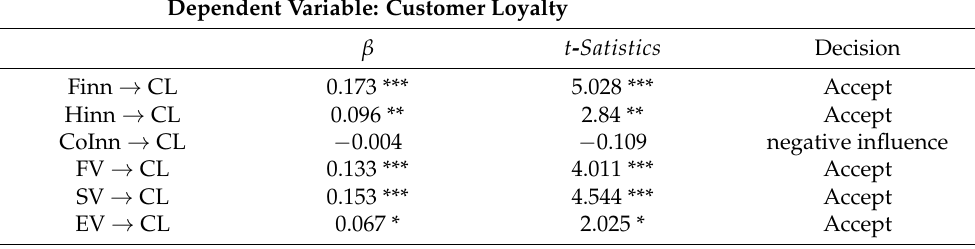
Table 5. Structural model I path analysis.